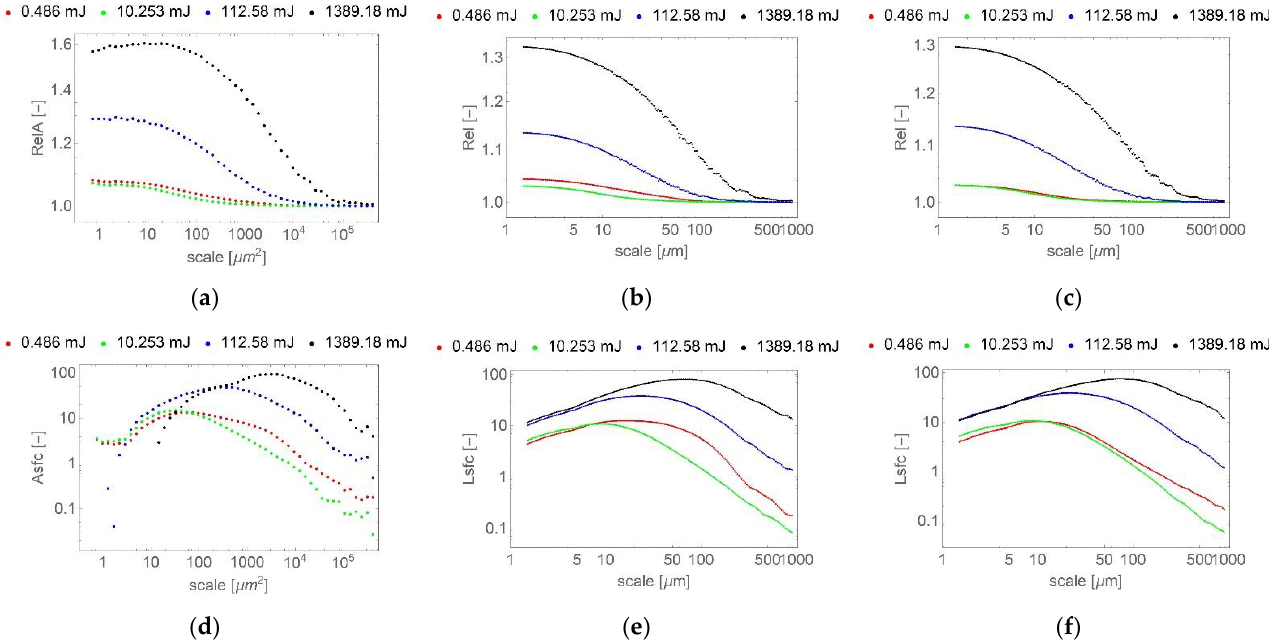
Figure 6. Area- and length-scale characterization parameters plotted as a function of scale for four different discharge energies: ( a ) relative area, ( b ) relative length (rows), ( c ) relative length (columns), ( d ) area-scale fractal complexity, ( e ) length-scale fractal complexity (rows), and ( f ) length-scale fractal complexity (columns).